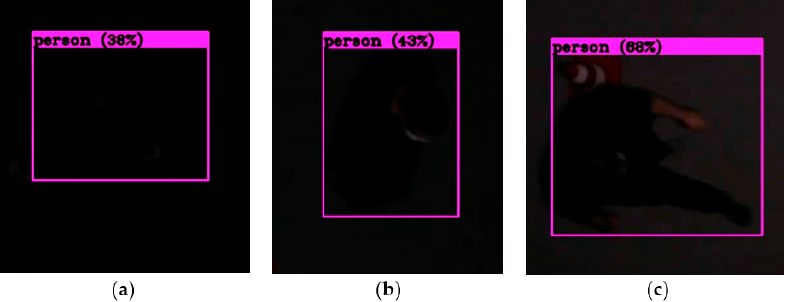
Figure 7. Pedestrian detection by YOLOv4 under the illumination of 8 lux. Exposure parameters: aperture = 3.5, shutter speed = 1/30, and ISO = 400 ( a ), 800 ( b ), and 1600 ( c ).